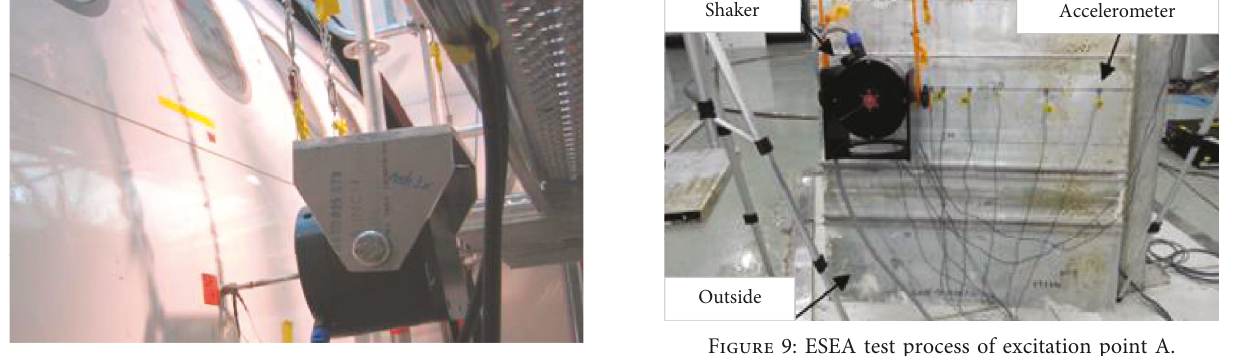
Figure 7: External transient impact load test process.